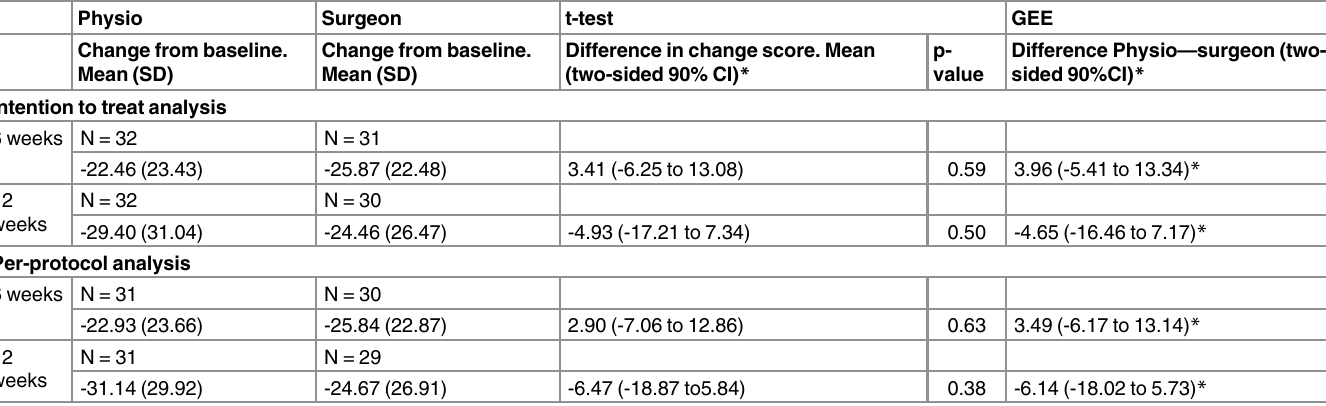
Table 3 details the secondary outcome measures. Hospital data showed that in usual service delivery, patients would have waited significantly longer to see the orthopaedic surgeon (356 days), than to see the physiotherapist (119 days). With the exception of the GROC on the day of injection (significant result in favour of the physiotherapist), there were no statistically sig- nificant differences between intervention groups at any point in terms of safety, clinical effi- cacy, patient satisfaction or resource usage (post-injection physiotherapy treatment and Table 2. Primary outcome: total Shoulder Pain and Disability Index. Physio Surgeon t-test GEE Change from baseline. Mean